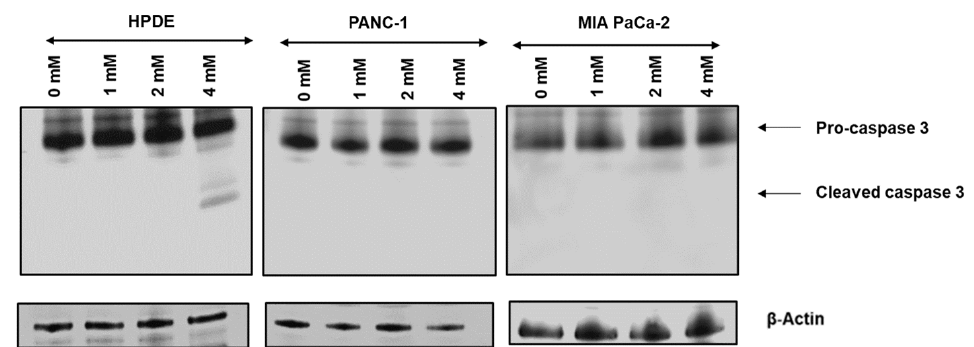
Figure 3. Western blot analysis of cleaved caspase-3 in HPDE, PANC-1, and MIA PaCa-2 cells treated with glyceraldehyde. Western blot was performed for three independent experiments for each cell type.